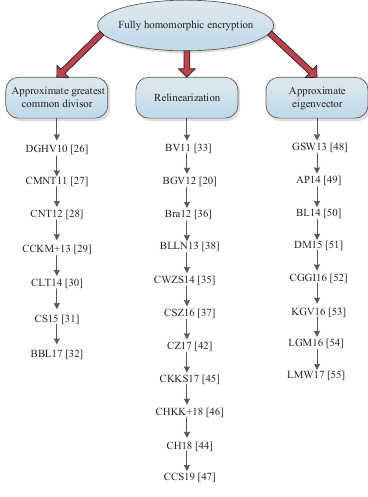
Figure 2. The development of fully homomorphic